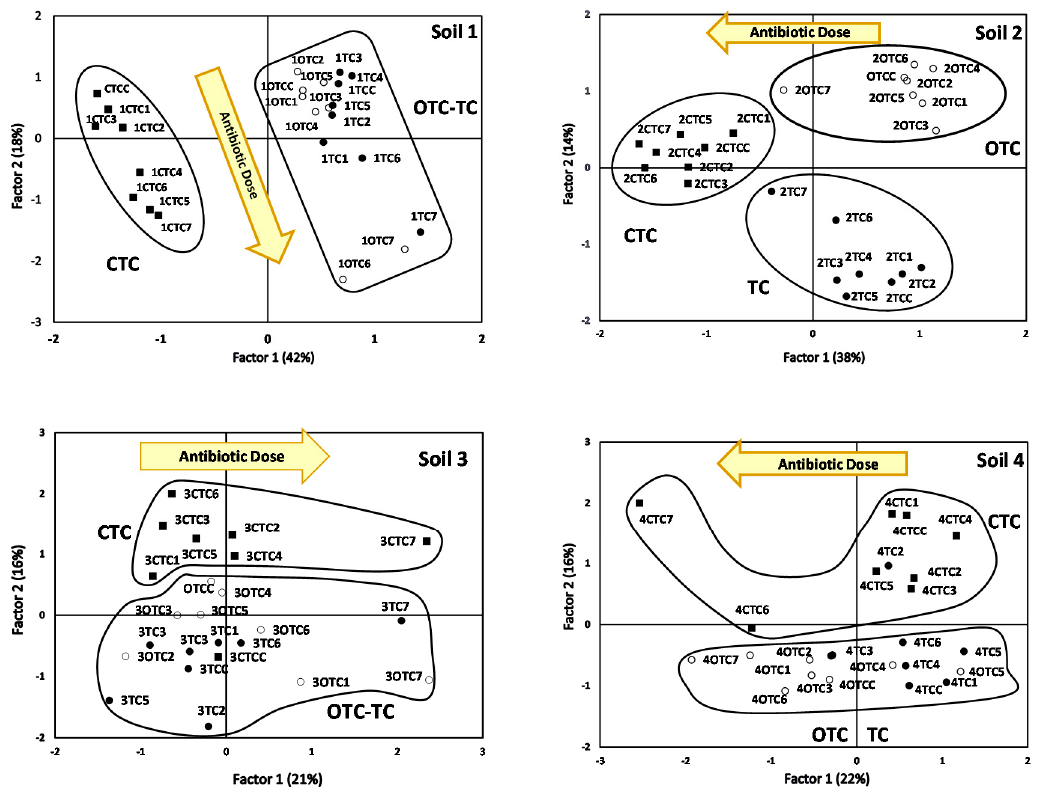
Figure 3. Principal component analysis (samples distribution) performed separately with the PLFA dataset of each studied soil (1, 2, 3, and 4) with eight different concentrations (0.00 (C), 0.49 (1), 1.95 (2), 7.81 (3), 31.25 (4), 125 (5), 500 (6), and 2000 (7) mg · kg − 1 soil) of the tetracycline antibiotics (CTC, chlortetracycline; TC, tetracycline; OTC, oxytetracycline) 42 days after